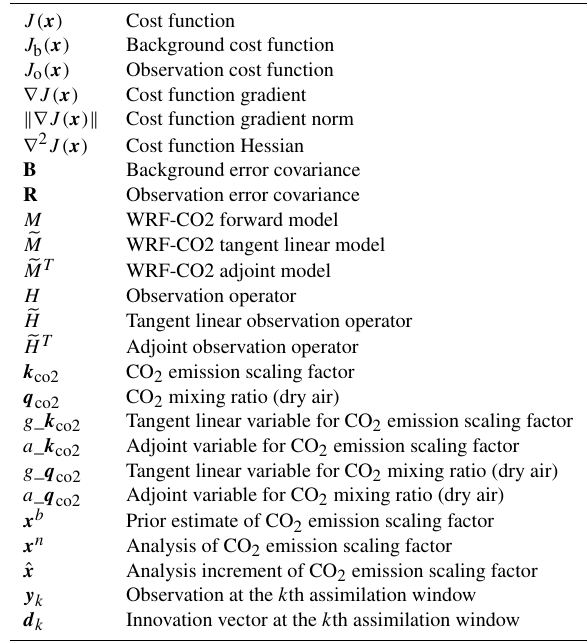
Table 1. A list of symbols used in this